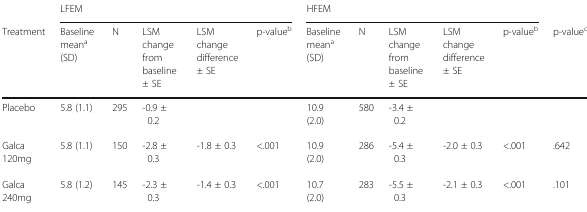
Table 1 (abstract O17). Monthly migraine headache days, average of months 1-6 LFEM HFEM Treatment Baseline mean a Table 2 (abstract O17). Monthly migraine headache days with acute medication use, average of months 1-6